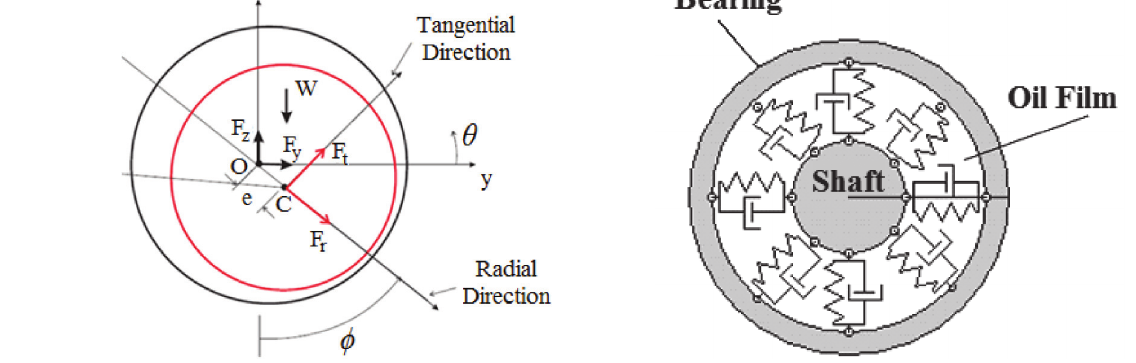
Figure 3 - Schematic representation of the reference system and the forces in the bearing.